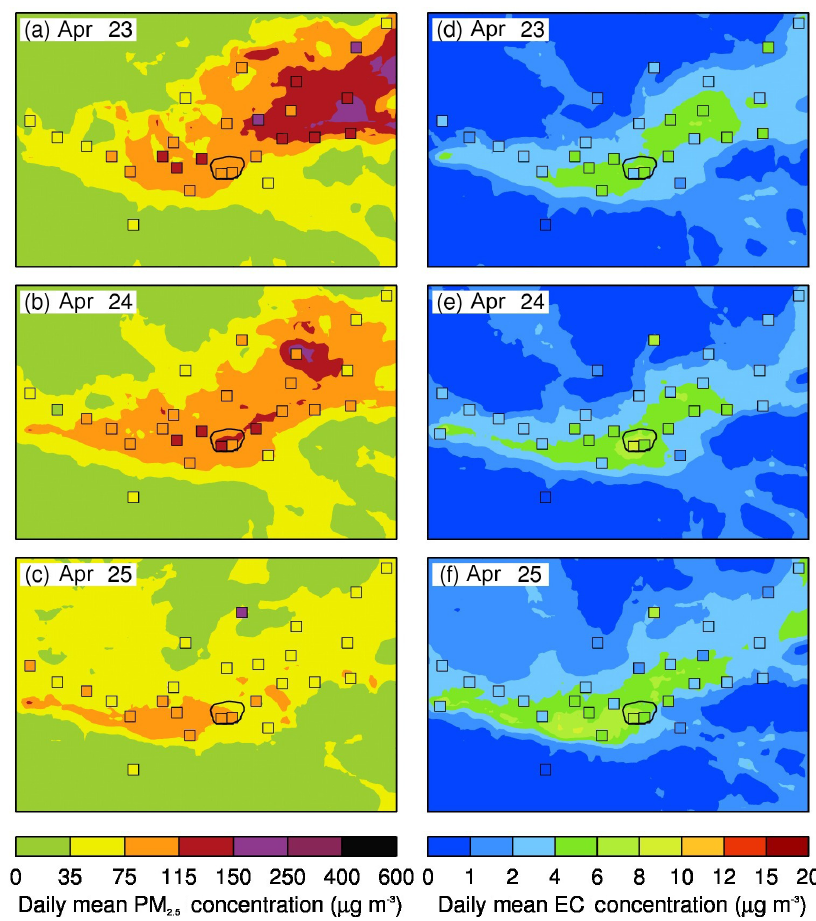
Figure 9. Spatial distributions of calculated (contours) and observed (squares) daily PM 2 . 5 (left column) and EC (right column) concentra- tions from 23 to 25 April 2013.